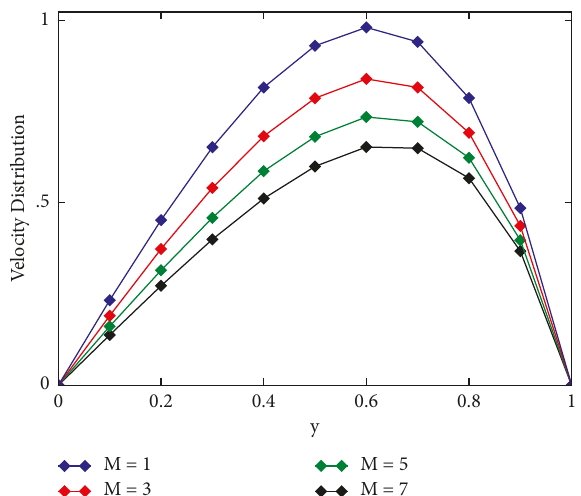
Figure 8: Heat source Q Impact on velocity when Pr